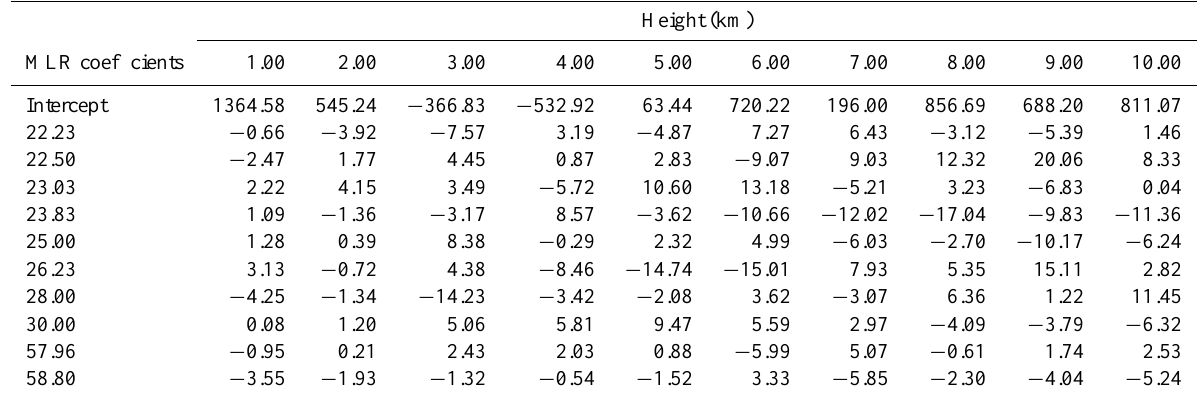
Table 1b. Same as Table 1a but for relative